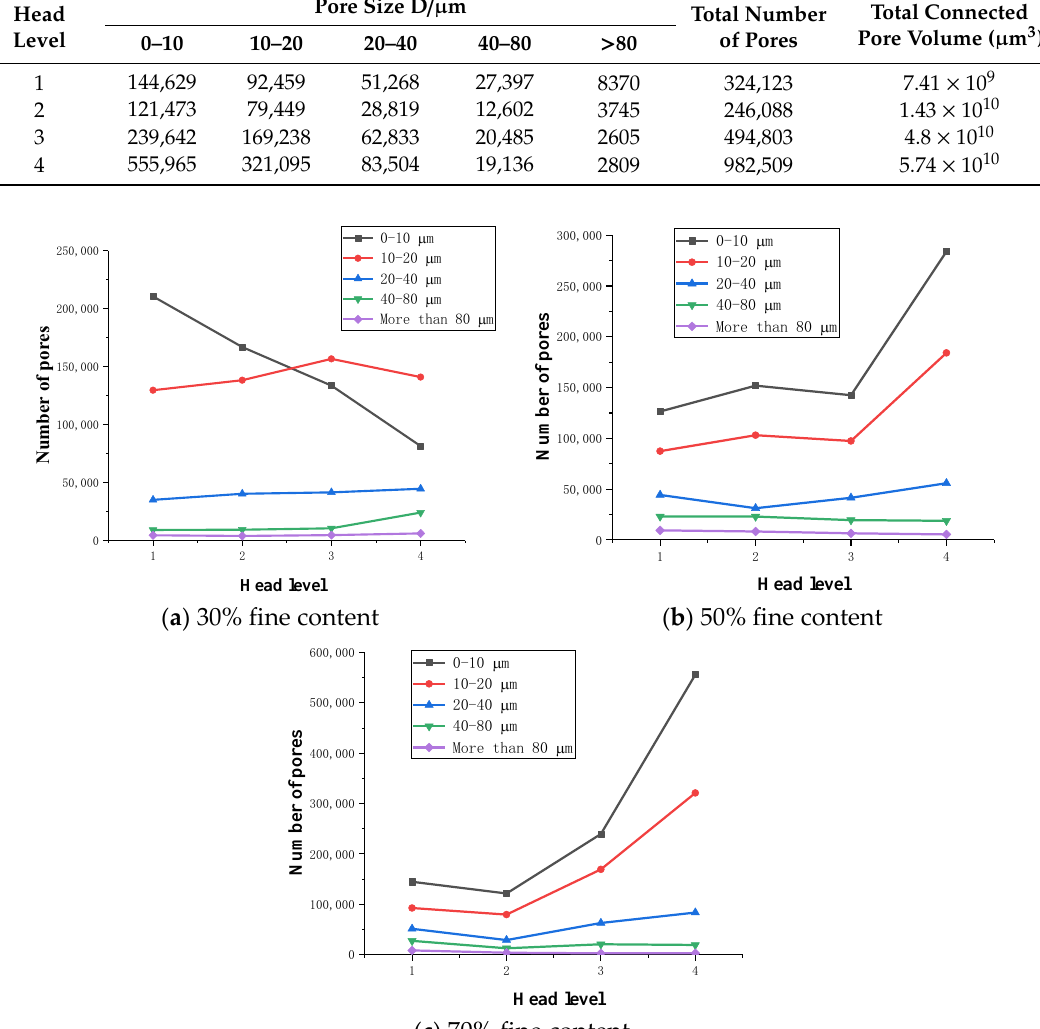
Table 6. Statistics of the number of pores in the seepage process with the 70% fine content. Pore Size D/µm Head Level